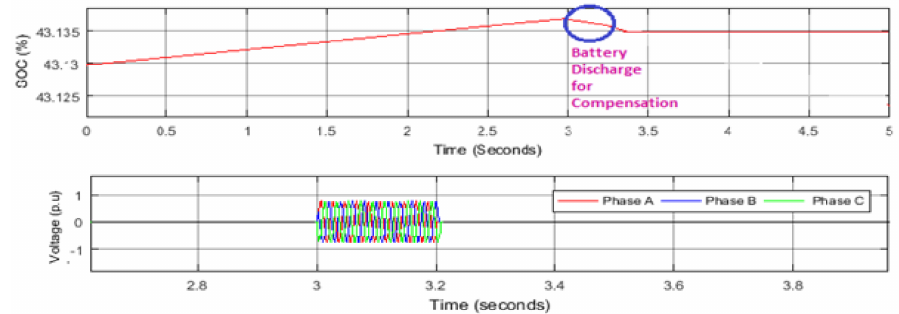
Figure 25. Battery charging and discharging during normal mode and fault ride through mode.